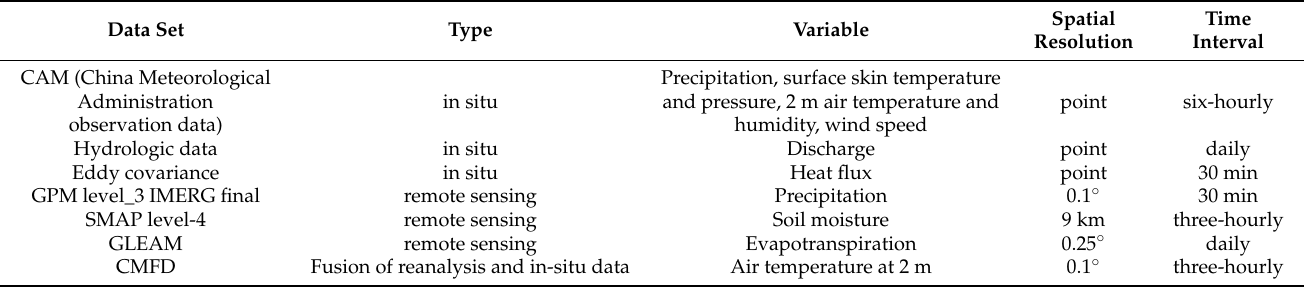
Table 1. Information of validation data, including China Meteorological Administration observation (CMA), Hydrologic data, Eddy covariance data, Global the Precipitation Mission (GPM) level_3 IMERG final product, the Soil Moisture Active Passive (SMAP) mission level-4 product, Global Land Evaporation Amsterdam Model (GLEAM), and China Meteorological Forcing Dataset